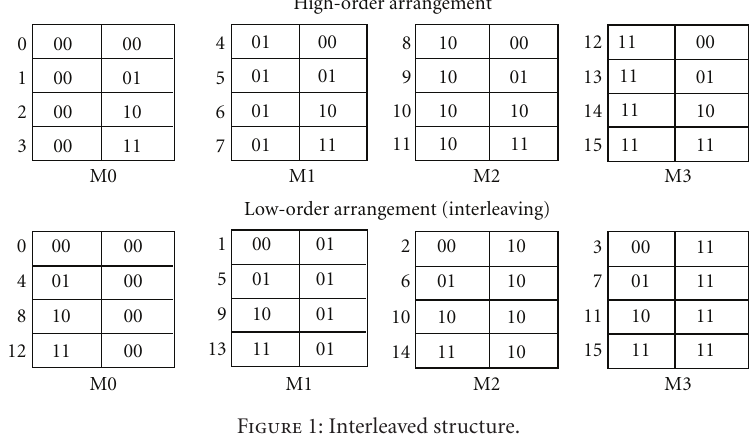
Figure 1: Interleaved structure.